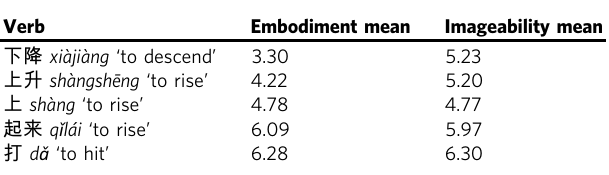
Table 2 Experimental results of embodiment and imageability of weather relevant verbs in Britton and Huang